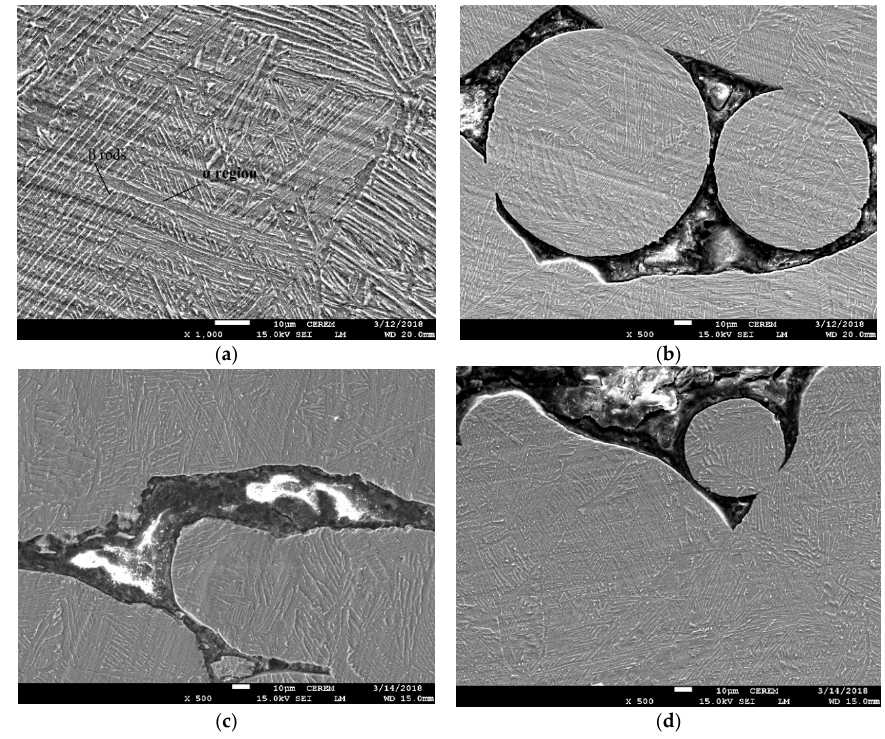
Figure 24. SEM images of 30-mm-diameter and 5-mm-thick cylinders, showing: ( a ) the base metal ( b )